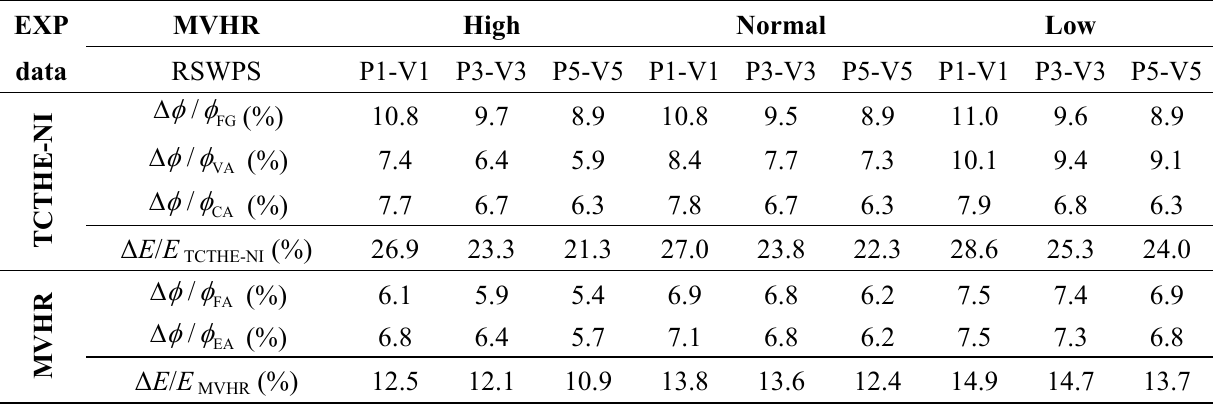
Table 6. Relative uncertainty of heat transfer rates and effectiveness within the TCTHE-NI and the MVHR